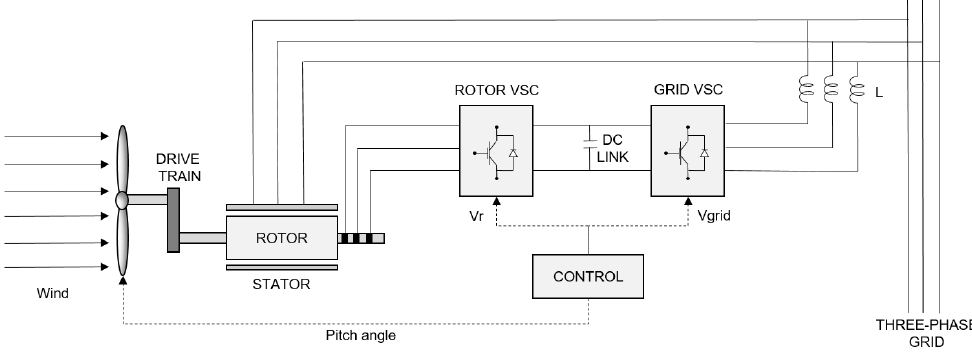
Figure 4. Structure of the DFIG wind turbine